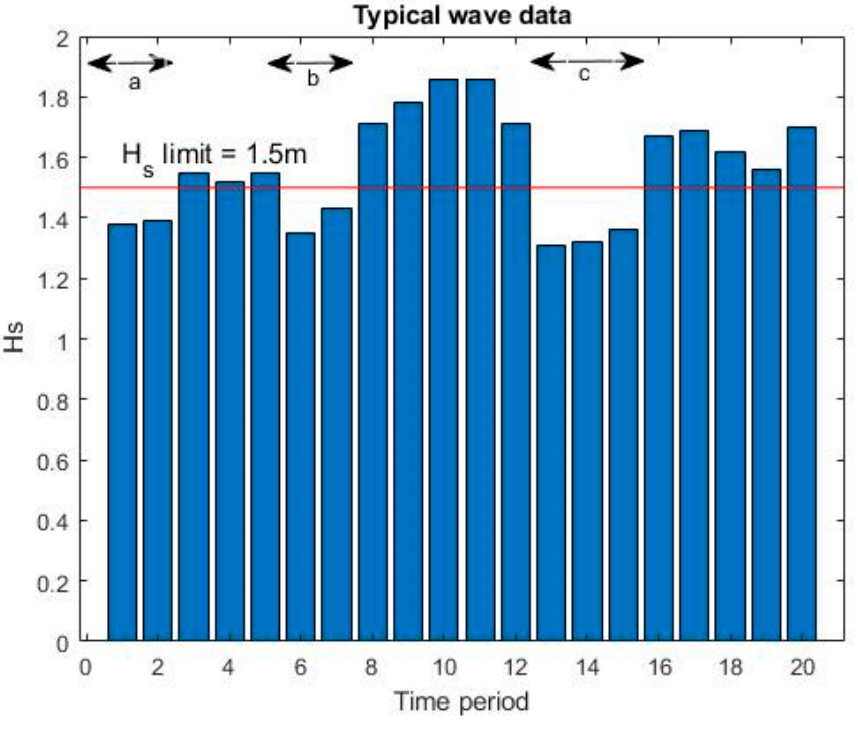
Figure 1. Weather window